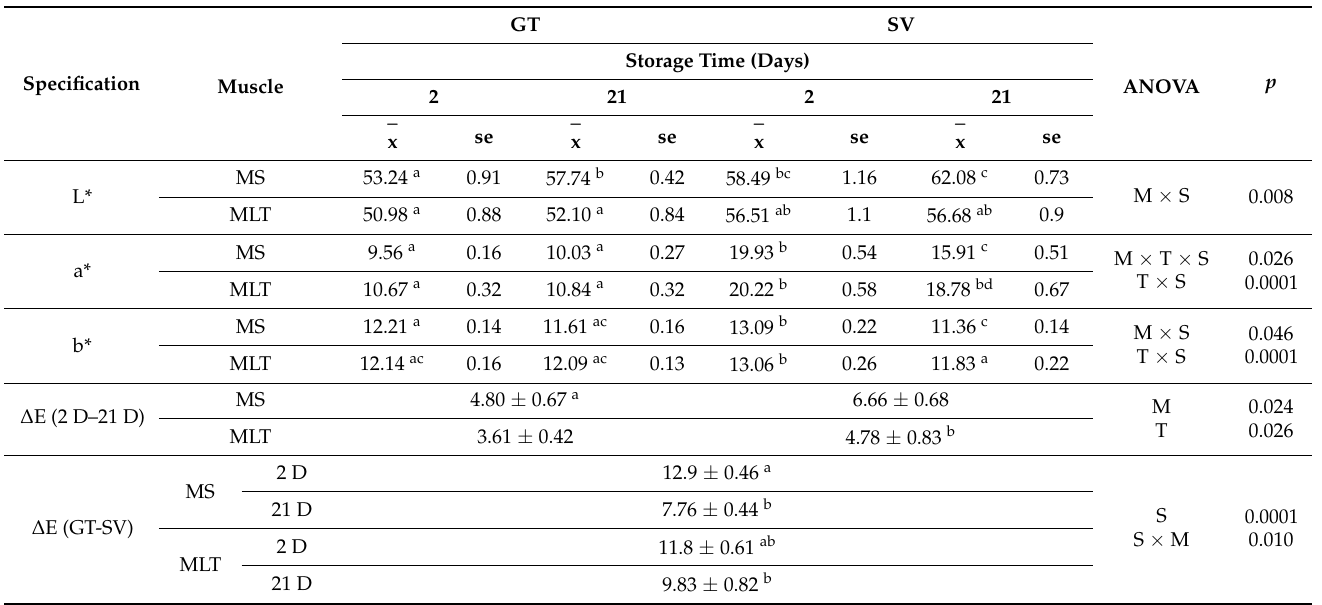
Table 4. Beef color parameters depending on the type of meat, cold storage time and thermal treatment